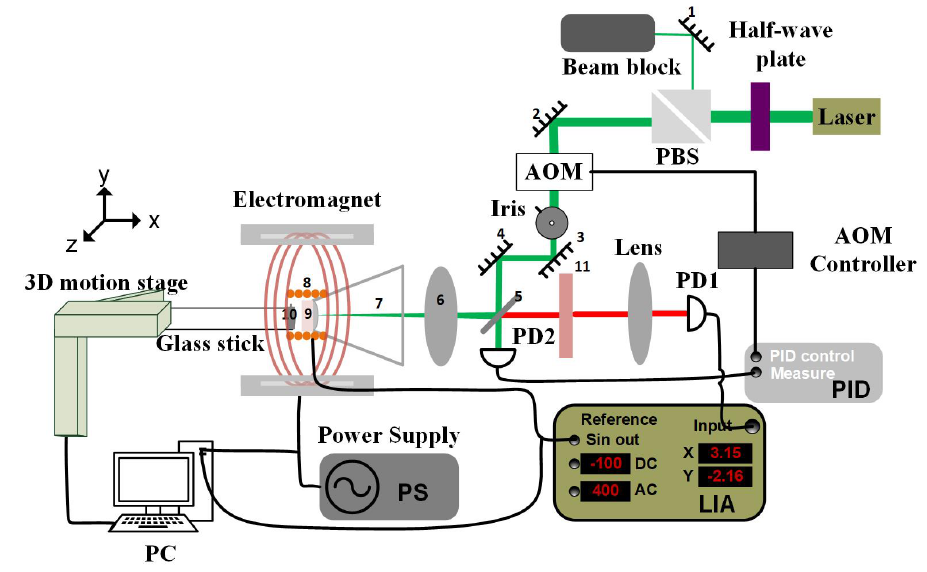
Figure 1. Experimental setup. 1–4: mirrors; 5: dichroic mirror; 6: lens; 7: parabolic concentrator; 8: RF coil; 9: diamond; 10: battery; 11: notch filter. PBS: polarizing beamsplitter; AOM: acousto-optic modulator; PD1,2: photodiodes; PC: personal computer; PS: power